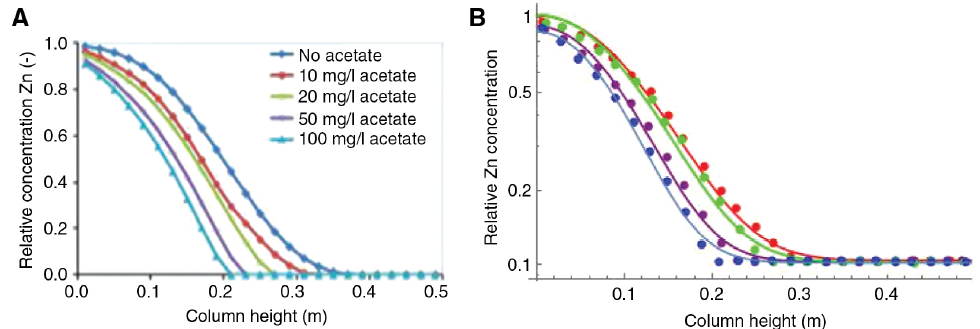
Figure 2: (A) Zn removal profile after 100 days in case of carbon source intrusion (bioremediation condition). Assumed: 60 mg/l sulfate. (B) Comparison between theoretical predictions and simulation results [22].